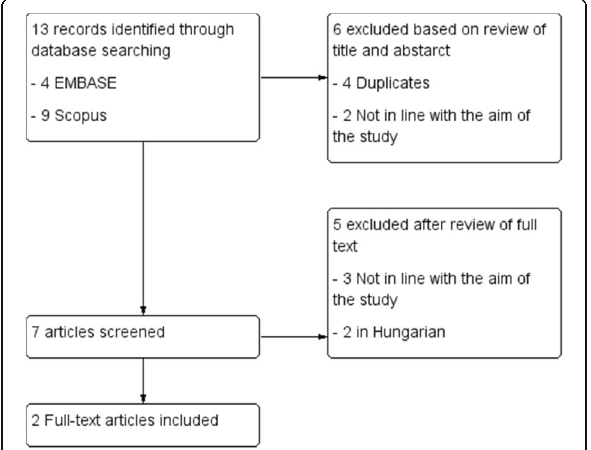
Fig. 1 Flow diagram for identifying studies included in the